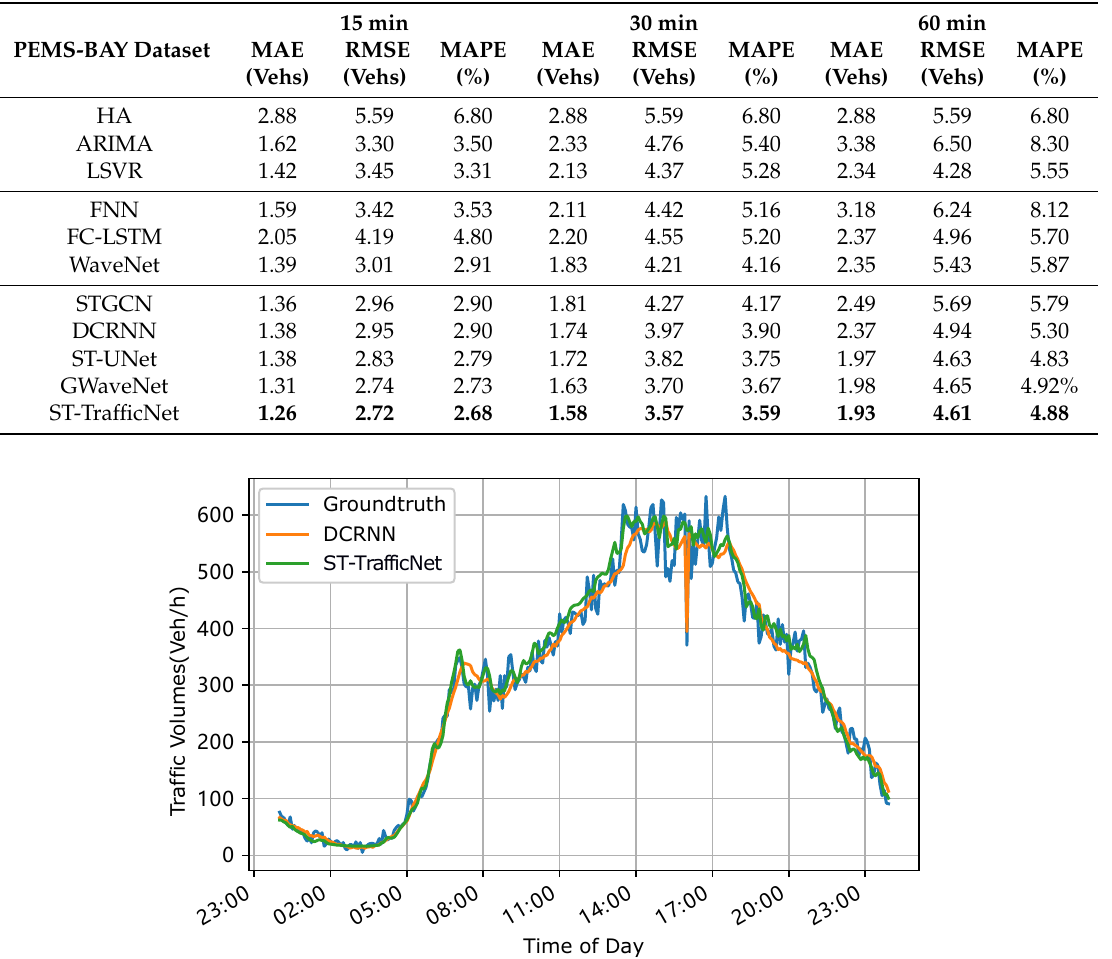
Table 2. Performance comparisons with baseline methods on PEMS-BAY dataset. Our ST-TrafficNet achieves the best results.